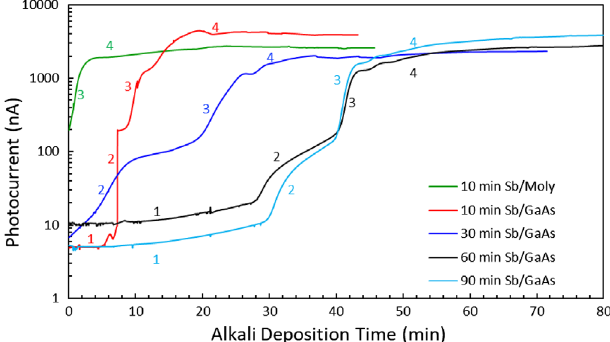
FIG. 4. Measured photocurrent versus alkali deposition time for photocathodes fabricated on GaAs and molybdenum substrates for different Sb deposition times. Stages 1, 2, 3, and 4 show the dominant processes in photocurrent evolution as described in the text.